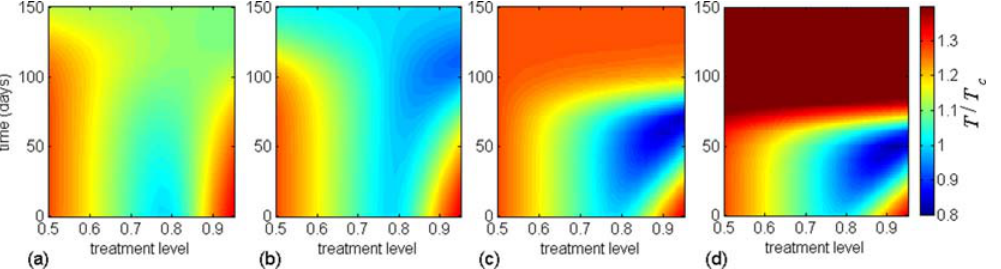
Figure 5. The effect of changing treatment level during a pandemic on the total number of clinical infections caused by all strains, ~ 1 : 6 . Simulations were seeded with an initial treatment level of (a) 85%; (b) 78% (optimal level); (c) 50%; (d) 25%, and then changed to the with R w 0 level shown on the horizontal axis at the time displayed on the vertical axis (corresponding to the time-course of the epidemic). The color bars illustrate the total number of clinical cases due to all strains, relative to that generated when the optimal constant treatment level (78% in this case) is implemented.